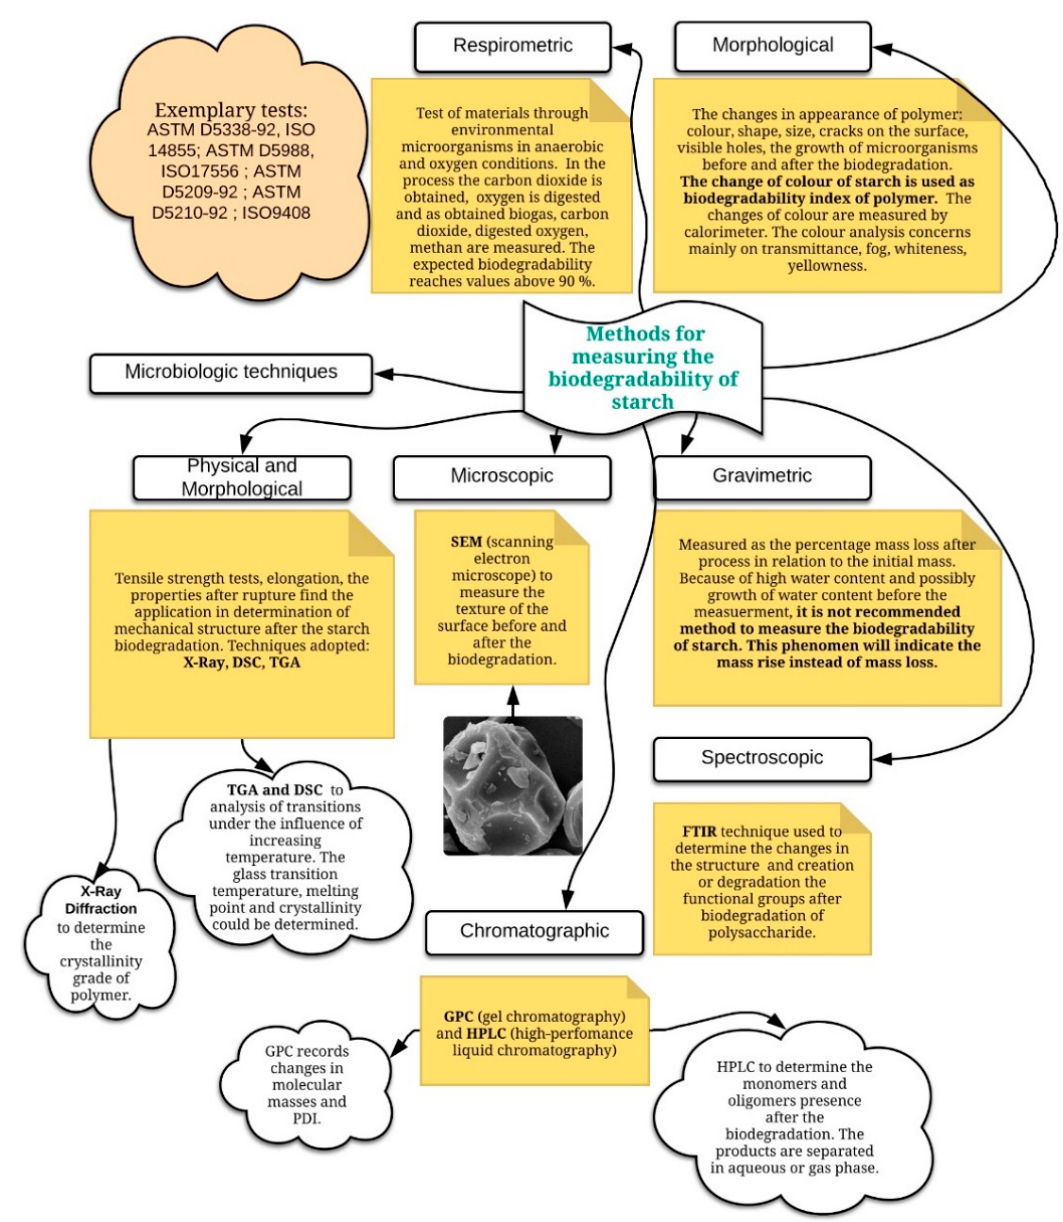
Figure 1. Methods for measuring the biodegradability of starch [13].